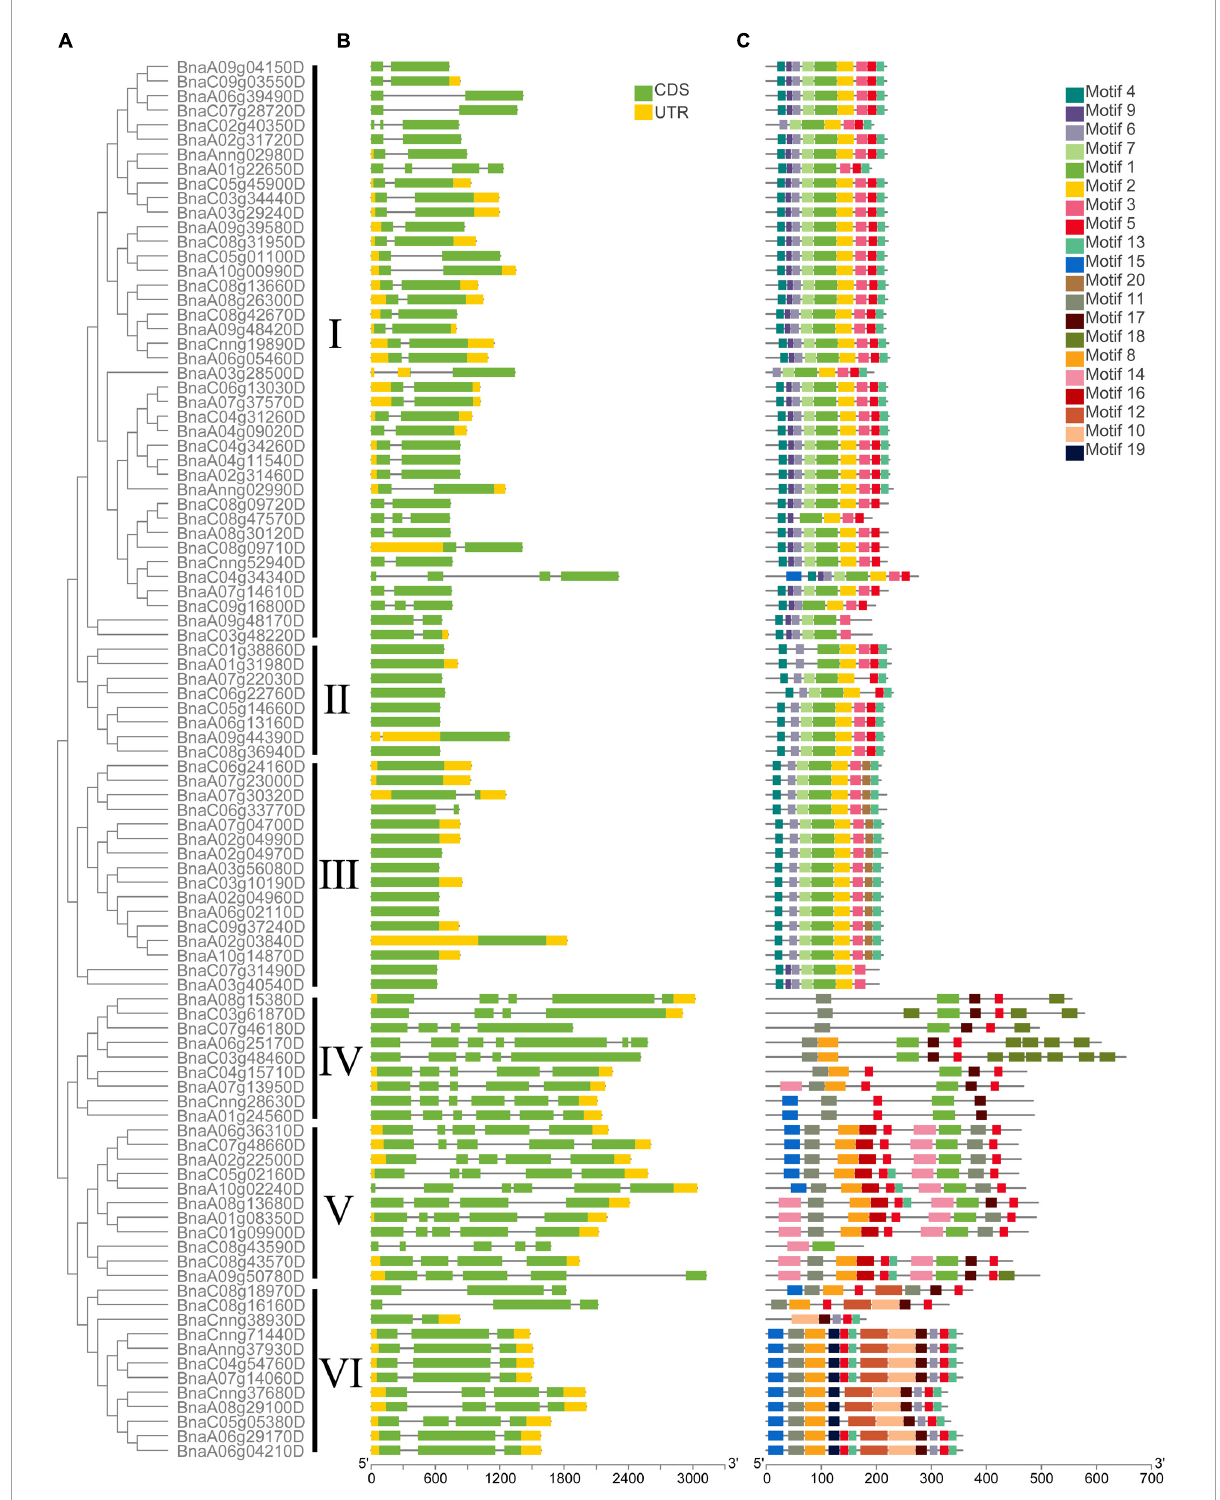
FIGURE3 The phylogenetic relationship, exon-intron architecture, and conserved motifs of 96 BnCDP in Brassica napus . (A) The phylogenetic relationships of BnCDP proteins based on the NJ method. (B) Gene structures of BnCDP genes. Yellow boxes represent the untranslated region (UTR), green boxes represent exons and the gray lines represent introns. (C) The conserved motif composition of BnCDP proteins. Scale bars represent gene length (bp) and protein sequence length